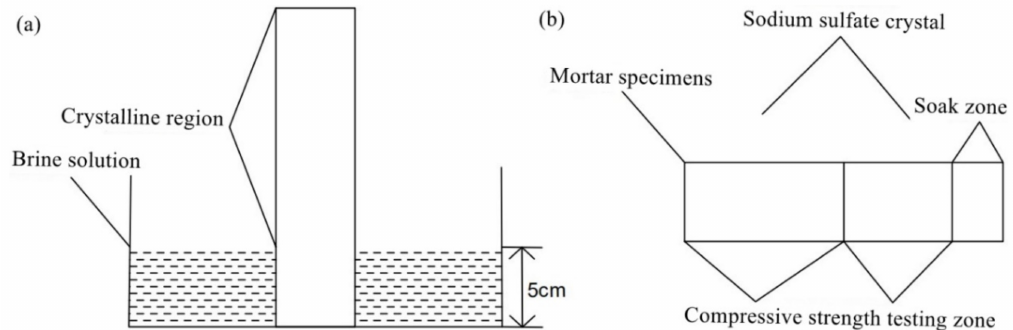
Figure 3. Diagrams of semi-immersion test ( a ) and compressive strength test ( b